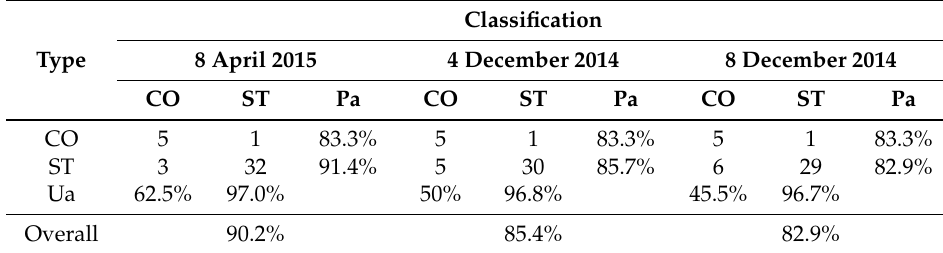
Table 3. Classification results with only second-order statistics (CO = totally collapsed building, ST = standing building; Pa = producer’s accuracy, Ua = user’s